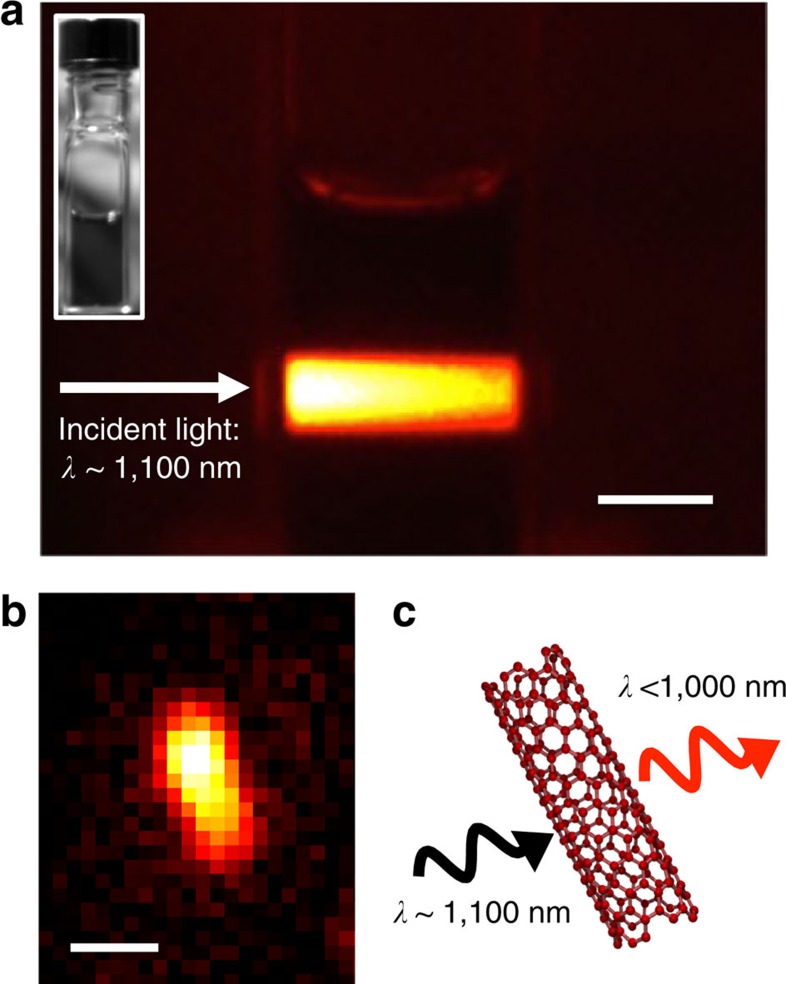
Up-conversion light emission of carbon nanotubes.(a) Optical image showing light emission from (6,5)-rich carbon nanotubes dispersed in D2O using surfactant (sodium dodecyl benzene sulfonate, Methods section) excited by incident light of wavelength ∼1,100 nm (selected wavelength range of 1,075–1,125 nm, power density=200 mW cm−2, collimated). The photoemission image was selectively detected in the 950–1,000 nm wavelength range using optical filters. The micelle-suspended nanotube dispersion was placed in a quartz cell (inset). Scale bar, 5 mm. (b) Microscopic image of the up-conversion light emission from an individual nanotube taken under the same excitation wavelength (∼1,100 nm) used in the experiment shown in a. Approximate excitation power density was 4 kW cm−2 (Methods section). Scale bar, 1 μm. (c) Optical processes observed in the experiment shown in a and b. A shorter wavelength (higher energy) photoemission (<1,000 nm) results from excitation at longer wavelength (lower energy) incident light (∼1,100 nm).